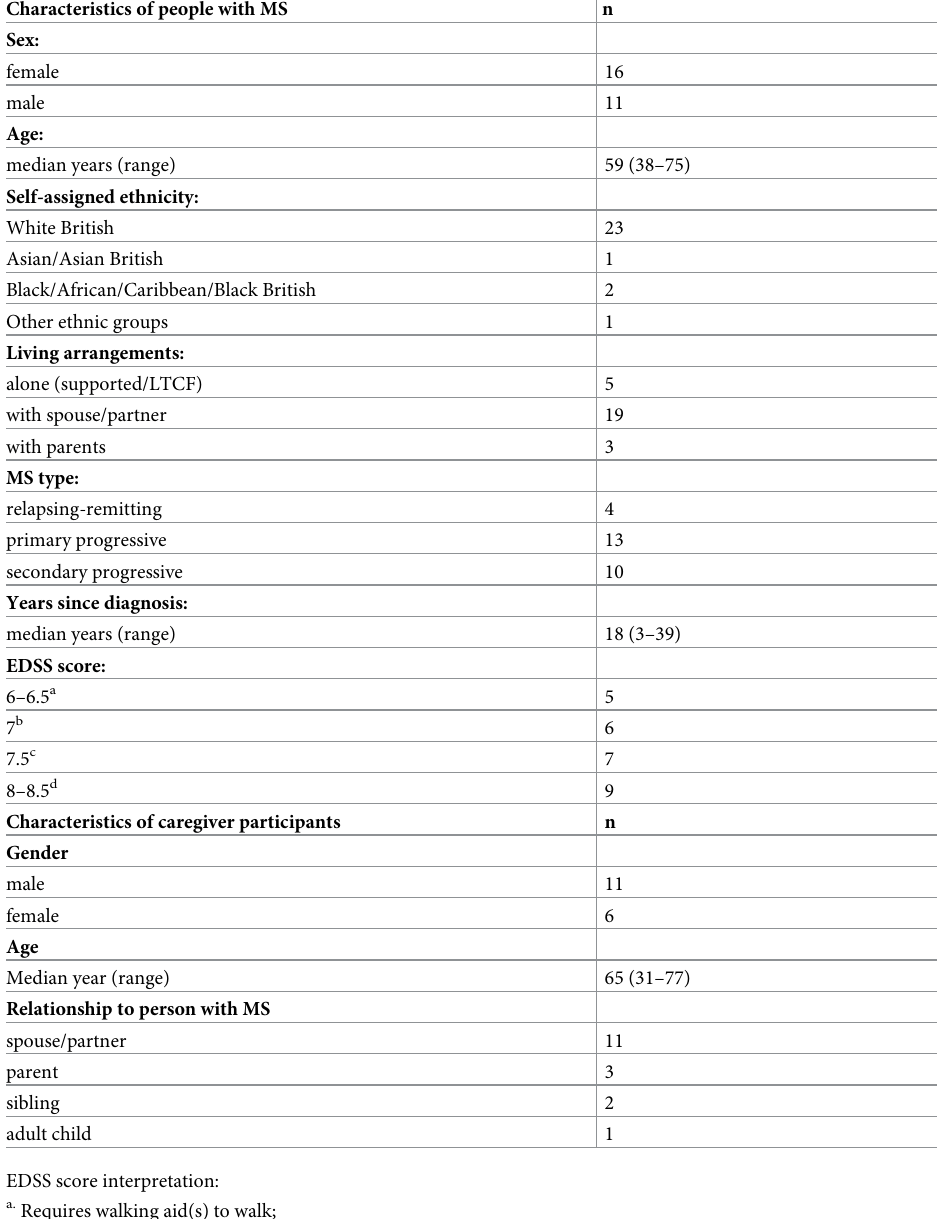
Table 3. Characteristics of